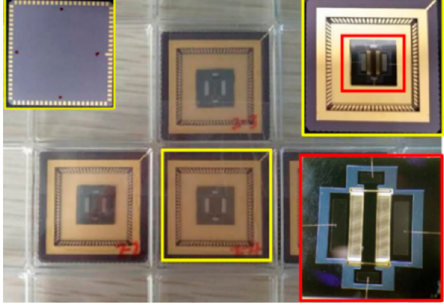
Figure 16. Photograph of the packaged chip.